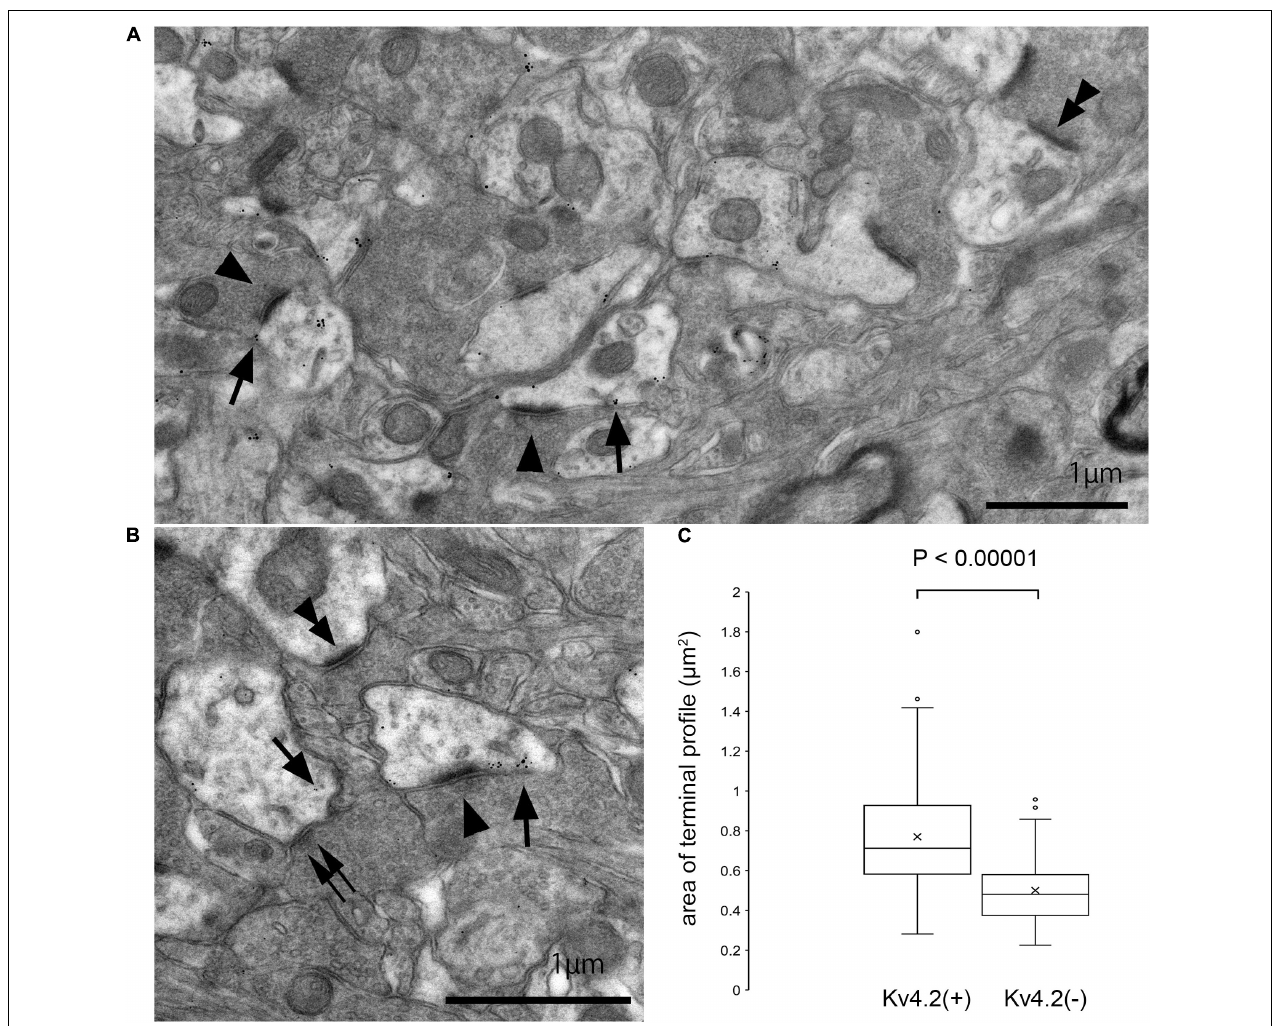
FIGURE 7 | Formation of synapses between Kv4.2-positive and negative postsynaptic MGB microregions and VGluT2 excitatory terminals. (A,B) Examples of asymmetric excitatory synapses in the MGV using pre-embedding immunoelectron microscopy. Arrow: Kv4.2 (gold colloid), arrowhead: asymmetrical synapse that is in the contact with Kv4.2-positive postsynaptic structure, double arrowhead: asymmetrical synapse that is in the contact with Kv4.2-negative postsynaptic structure, and double arrow: symmetrical synapse that is in the contact with Kv4.2-positive postsynaptic structure. (C) The area of axon terminals of those asymmetric synapses that are in contact with gold particles positive or negative postsynaptic structure. Terminals forming asymmetric synapse with Kv4.2-positive MGV dendrites are significantly larger than those forming synapses with Kv4.2-negative MGV dendrites ( P < 0.00001, t -test). Scale bar: 1 µ m (A,B) . The horizontal lines in the box and whisker plots represent the median values, and the bottom and top of the boxes represent the lower and upper quartiles, respectively. The “x” represents the mean and the bars represent the minimum and maximum values within 1.5 times the lower and upper quartiles. Kv4, Shal-related subfamily of potassium voltage-gated channel; MGV, ventral medial